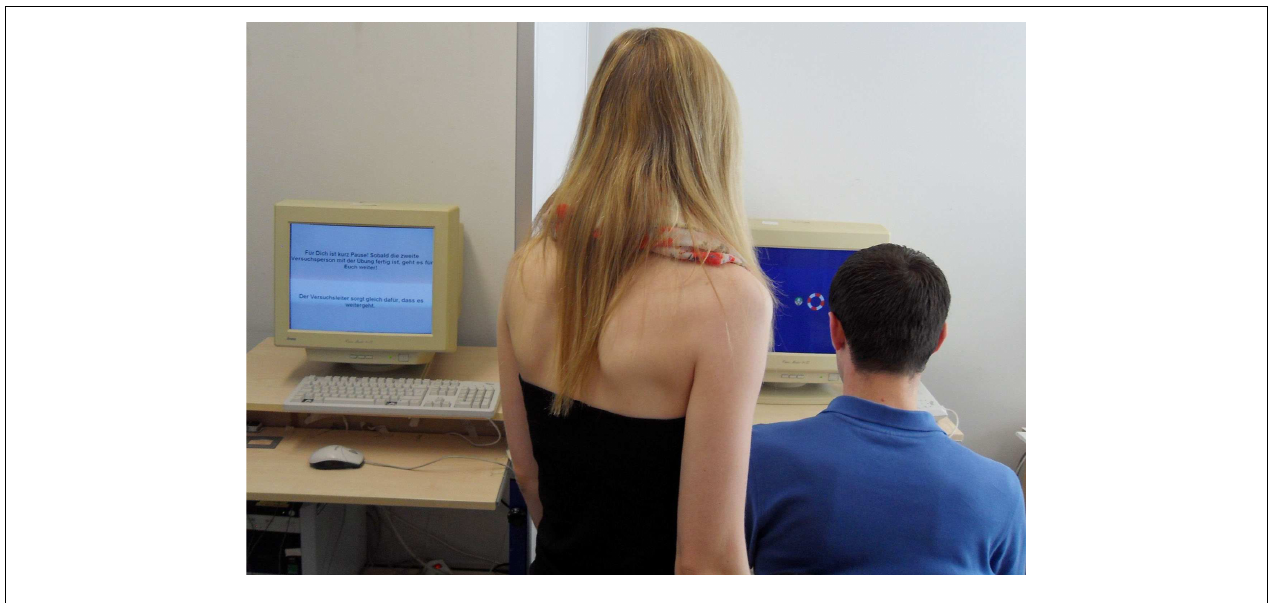
“own” effect, the yellow life buoy. After the instruction phase each participant performed the task on his/her computer separated by the divider wall.Throughout experimental trials both participants wore headphones delivering white noise to ensure they did not hear button